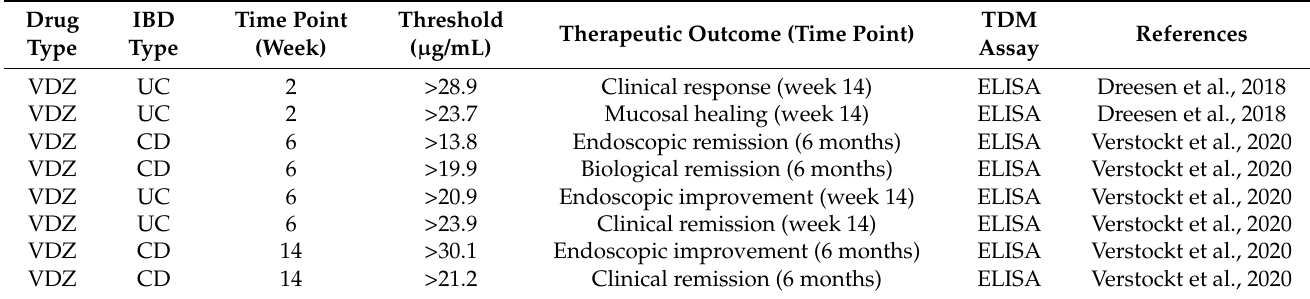
Table 1. Serum biologic drug concentration thresholds can vary based on inflammatory bowel disease (IBD) phenotype and the desired therapeutic outcome to target. Adapted from